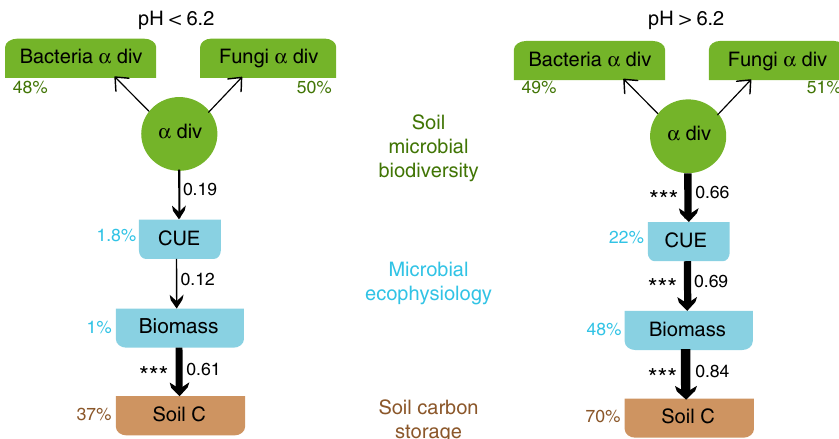
Fig. 3 Model outcome of expected causal relationships. Most fi tting paths of causality obtained through structural equation modeling for the two datasets across the soil pH threshold value of 6.2 (pH < 6.2: n = 50, CFI = 1, RMSEA = 0, SRMR = 0.079, AIC = 693, P = 0.67; pH > 6.2: n = 113, CFI = 1, RMSEA = 0, SRMR = 0.039, AIC = 1396, P = 0.57). Percentage fi gures next to the variables indicate their explained variance ( R 2 ). Figures on the arrows indicate standardized path coef fi cients and asterisks mark their signi fi cance;